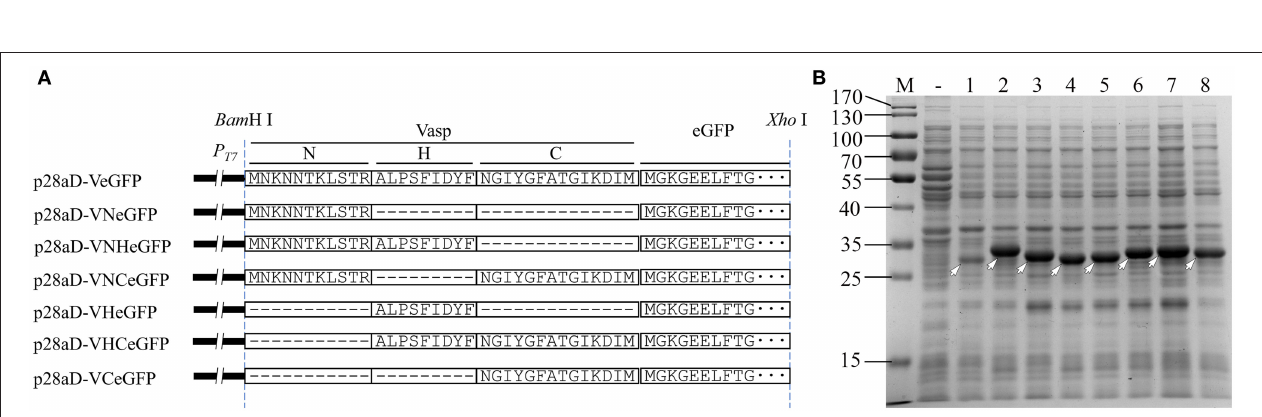
Frontiers in Microbiology | www.frontiersin.org